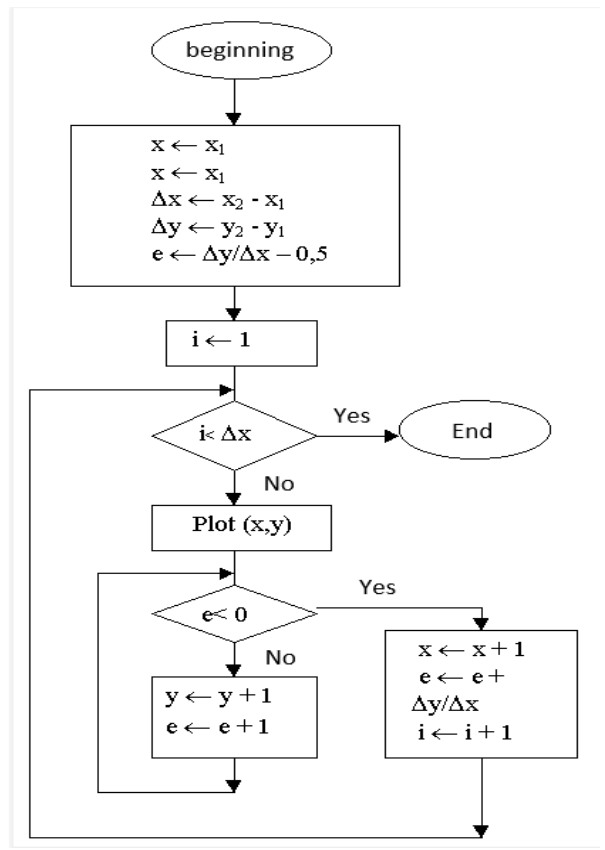
Figure 17. A flow chart.